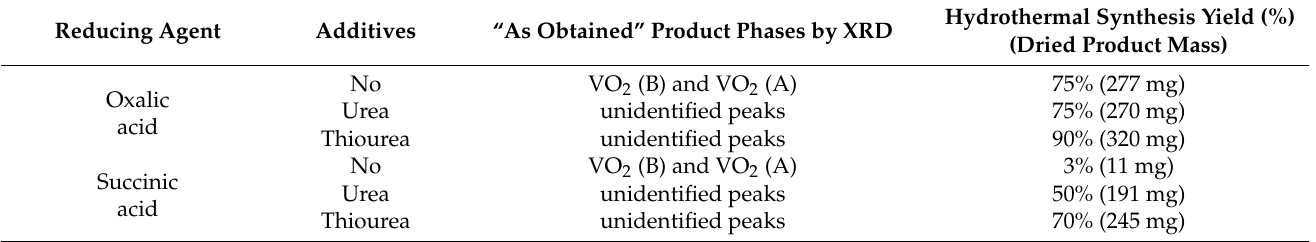
Table 1. Hydrothermal synthesis yield of hydrothermal reactions, by mass and percentage of